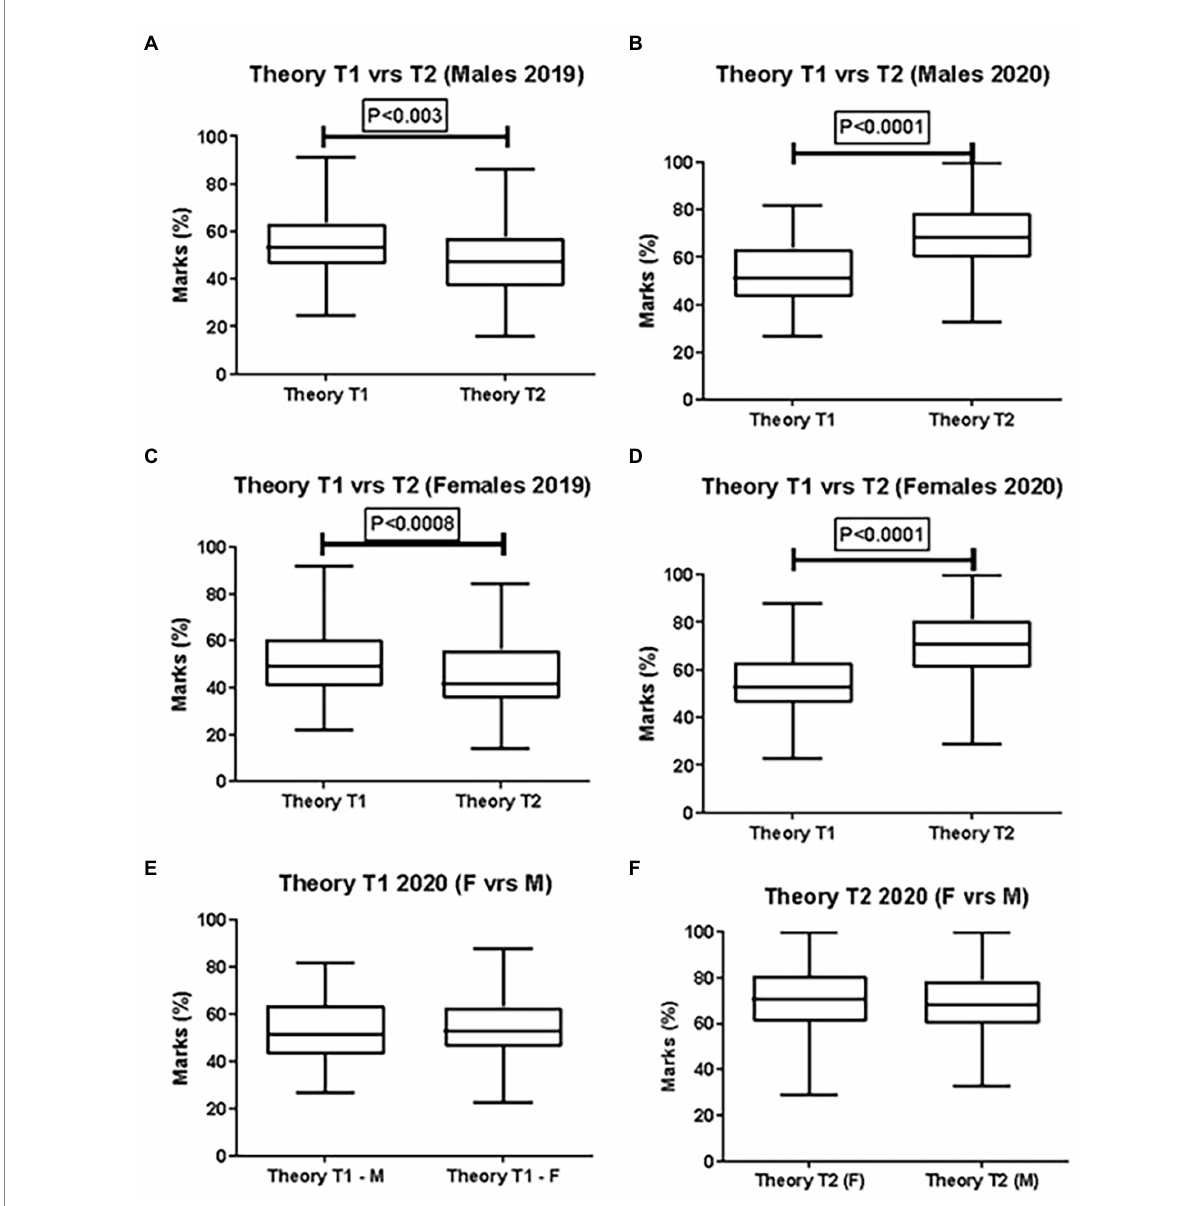
FIGURE 6 The graphs above present comparisons between the data gender subsets, and we compared the distribution of marks (%) for these subgroups of males (A,B) and females (C,D) . The distribution comparison between males and females is presented in graphs E , and F . Theory Tests (T) for 2019 and Theory Test 1 in 2020 was assessed in the normal sit-down method, while Theory Test 2 was a home-based online assessment of online lectures (COVID-19 lockdown